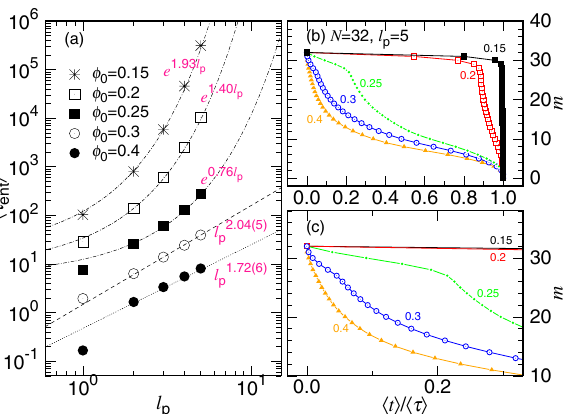
τ ent Figure 13. ( a ) as a function of ℓ p in log-log scales. The chain length is 32 and the value of φ 0 is indicated (cid:31) (cid:30) in the legend. ( b ) Descending of m plotted in the normalized time coordinate The φ 0 value is given near the corresponding curve. Panel ( c ) is a zoom-in of the panel ( b ) near the starting 32 point m =